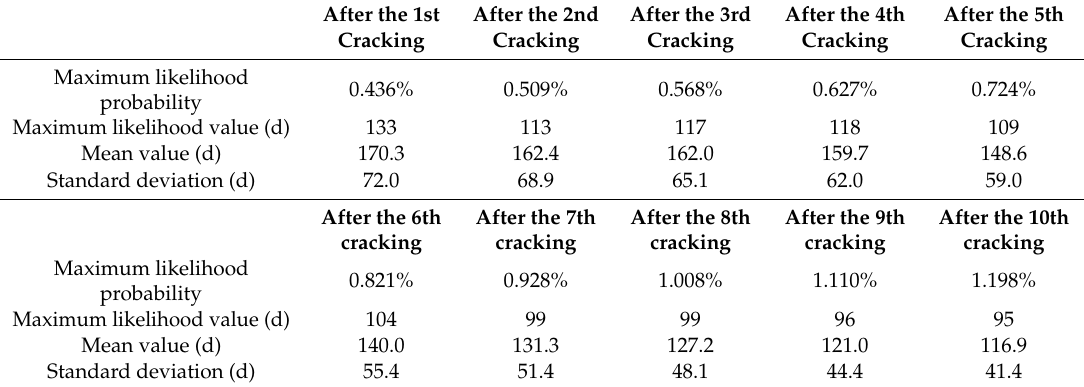
Table 5. Statistical characteristics of parameter λ